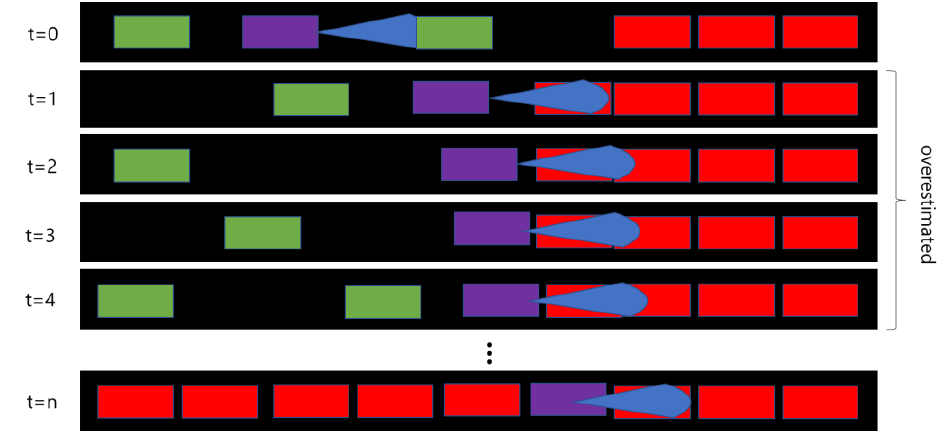
Figure 2. Overestimation pattern in time of onset of congestion.